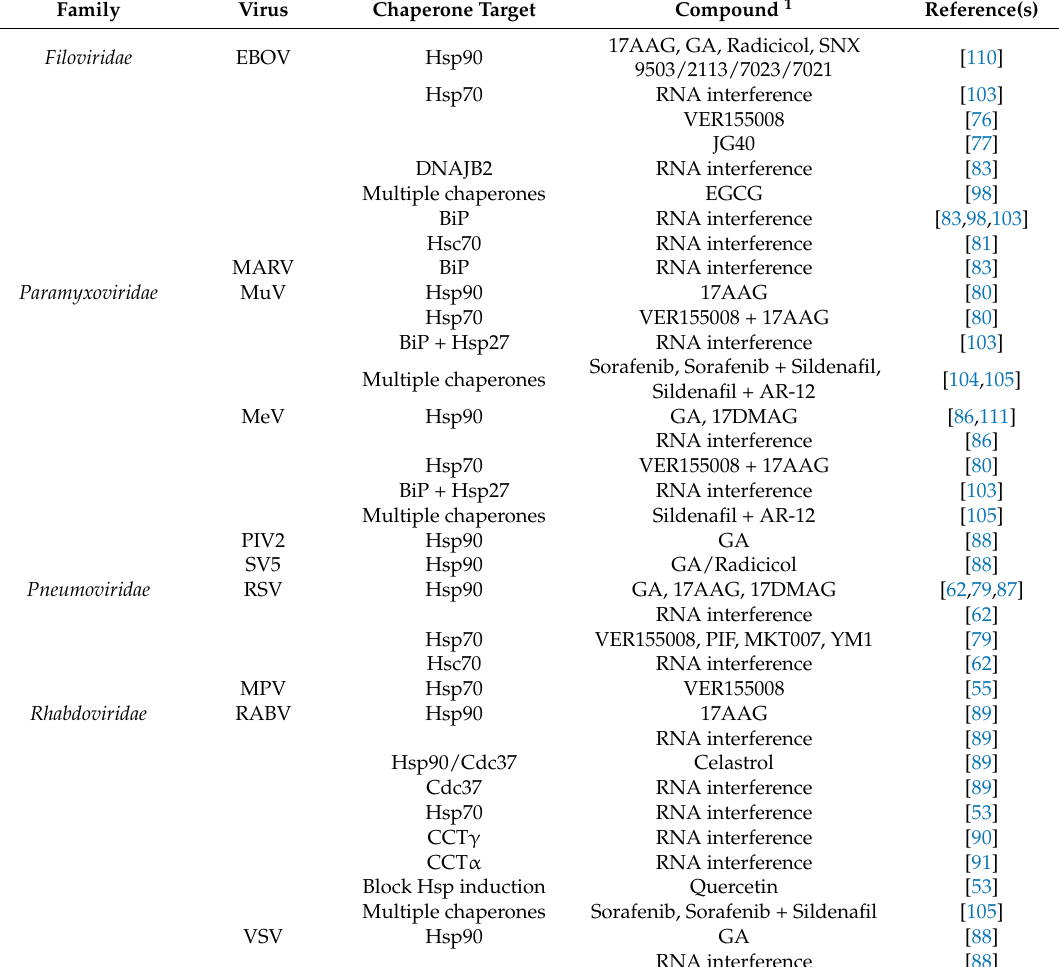
Table 1. Antiviral activity of chaperone inhibitors against the Mononegavirales